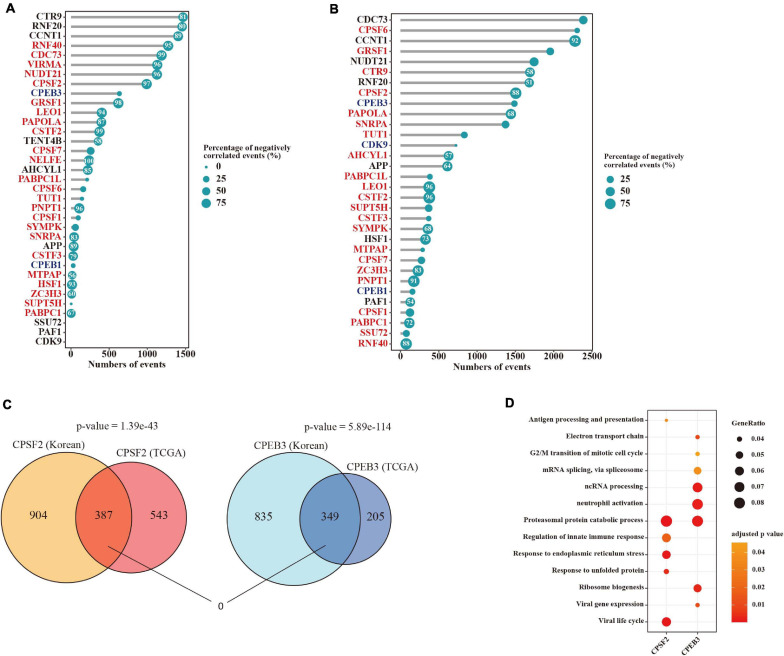
Potential mechanisms for APA regulation in LUAD. (A) Lollipop chart indicating the number of significantly correlated APA events with each regulator gene in the TCGA dataset. Dot size is proportional to the percentage of negatively correlated events. Numbers in the dots represent the percentages of negatively correlated events that are greater than 50%. (B) Lollipop chart indicating the number of significantly correlated APA events with each regulator gene in the Korea dataset. (C) Venn diagram showing the overlap of altered APA events correlated with CPSF2 or CPEB3 between the two datasets. (D) Dot plot indicating significantly enriched biological processes of events correlated with CPSF2 or CPEB3 in both two cohorts.